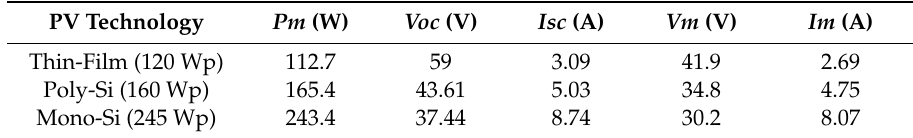
Table 5. Electrical characteristics of the modules under standard test conditions (STC) as certified by